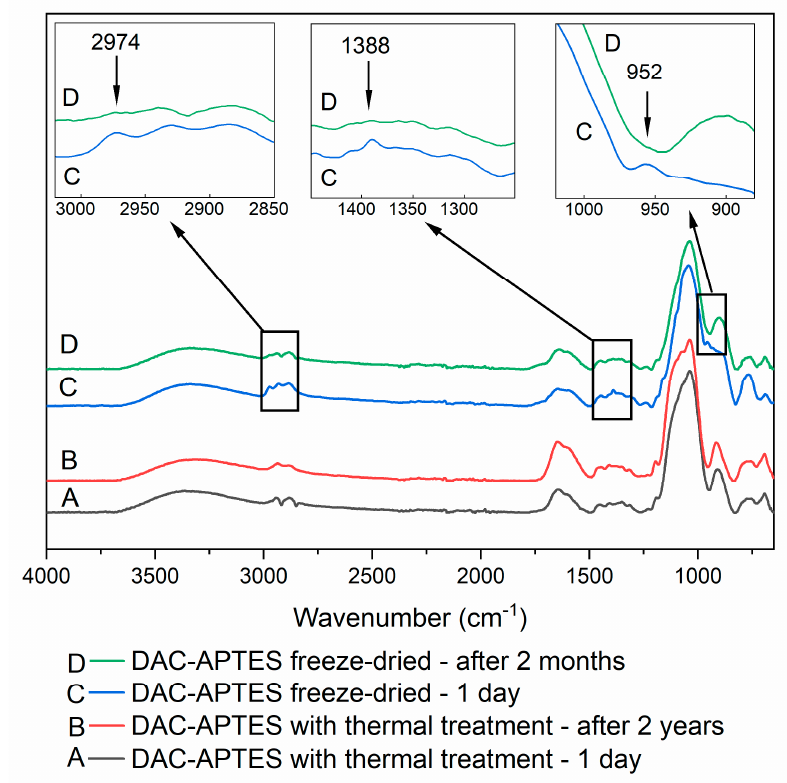
Figure 4. FTIR spectra of modified DAC with APTES for both processes, i.e., thermal treatment and freeze-drying treatment. The insets are showing the bands of unreacted APTES, which disappear in the freeze-dried samples after two months because of the instability of neat APTES.